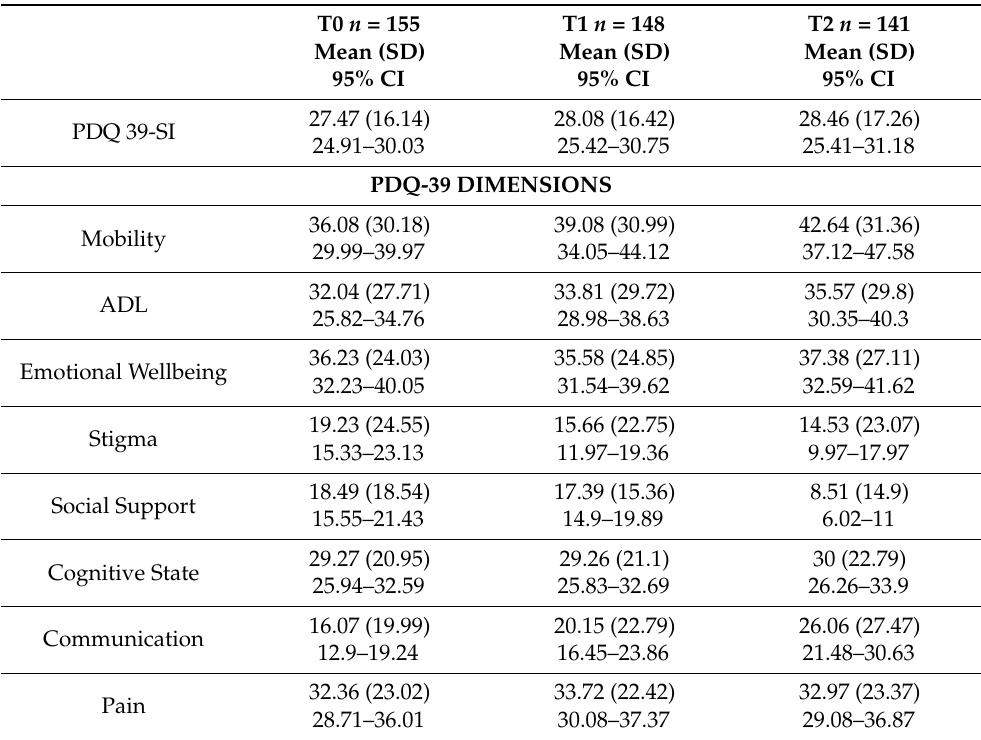
Table 2. Evolution of global HRQoL and each dimension of the PDQ-39 over the two years of follow-up (T0-T1-T2).